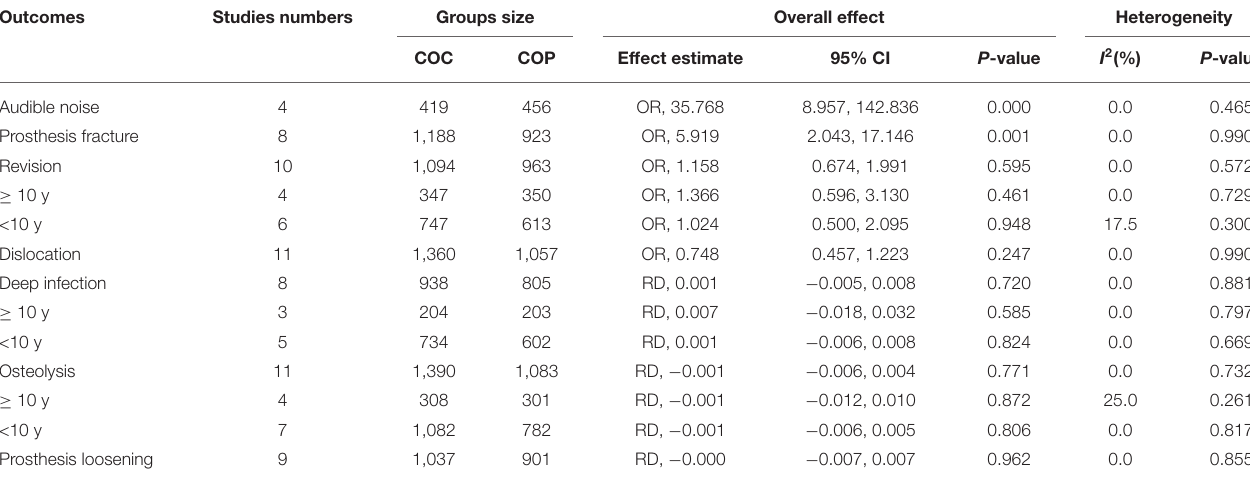
TABLE 4 | The postoperative outcomes of this meta-analysis.